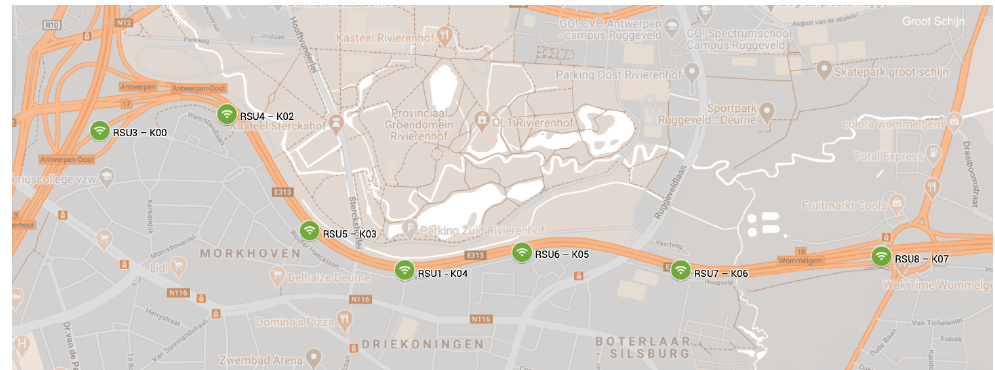
Figure 5. The positions of the Road-Side Units (RSUs) deployed along the E313 highway.